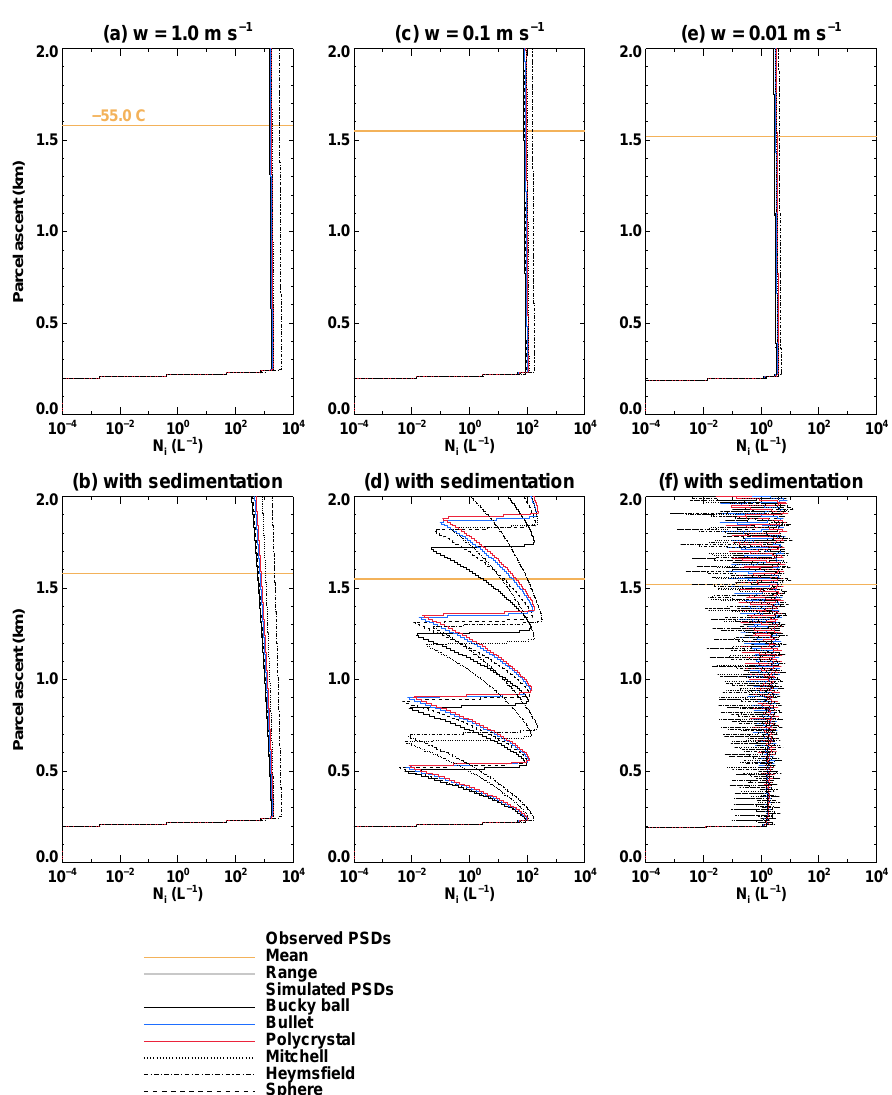
Figure 18. Simulated ice crystal number concentration as a function of parcel distance from initiation at − 40 ◦ C, with ice properties as in Fig. 14 (see legend) and updraft speeds of 1, 0.1, and 0.01ms − 1 without sedimentation (top row) and with sedimentation (bottom row). Parcel level corresponding to − 55 ◦ C corresponding to size distributions in Fig. 17 is shown as dotted yellow